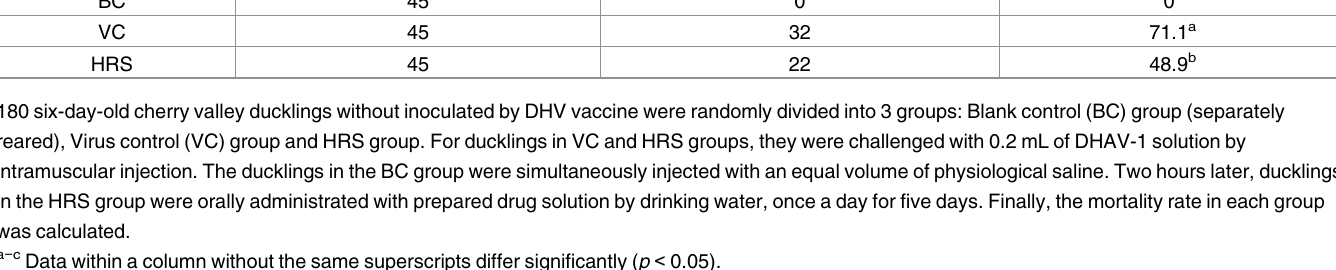
Table 1. Results of mortality rate of each group. Group Samples (feathers) Final deaths (feathers) Mortality rate (%) 45 45 48.9